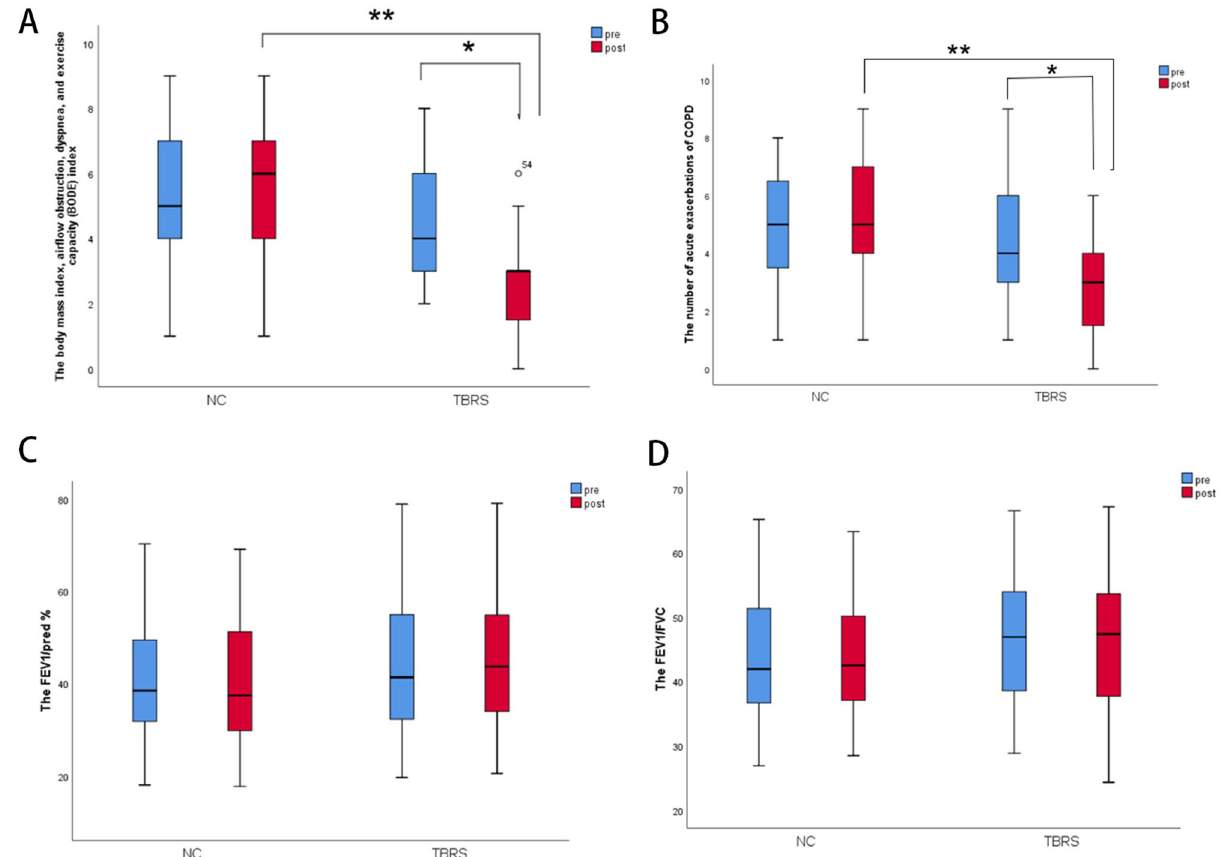
exacerbations of COPD; C, FEV 1 /pred%; D, FEV 1 /FVC; (* P = 0.00 compared with before intervention, ** P = 0.00 compared with the control